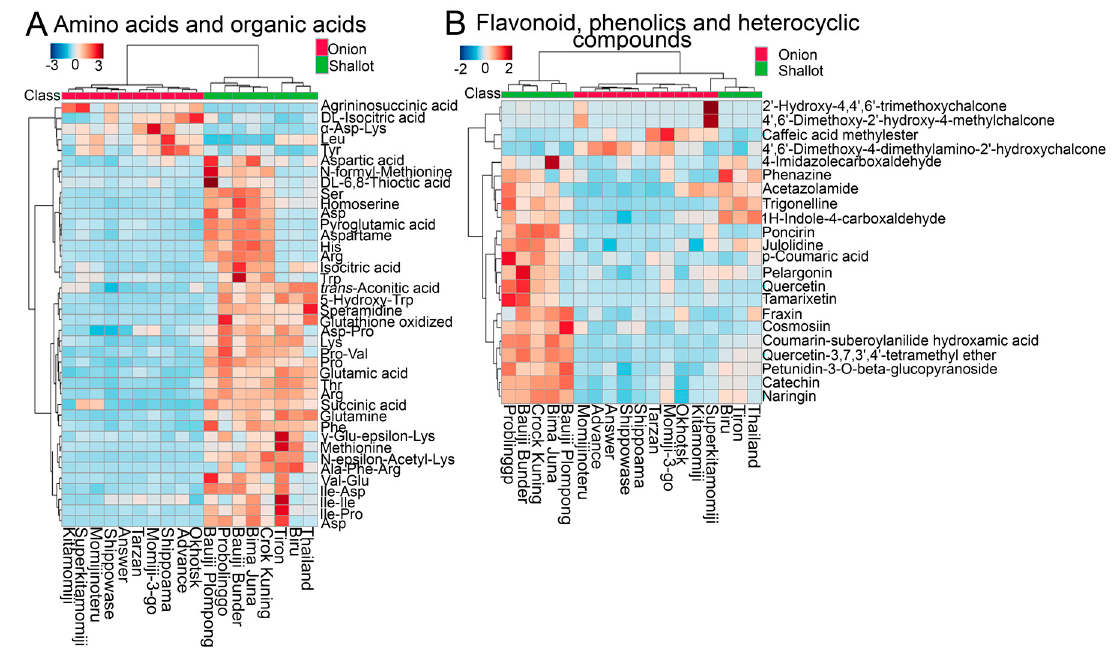
Figure 3. Heatmap hierarchical clustering of ( A ) amino acids and organic acids and ( B ) flavonoids, phenolics, and heterocyclic compounds identified in short-day and long-day Japanese bulb onion cultivars and Indonesian shallot landraces. The heatmap expression was generated using normalized metabolite signal